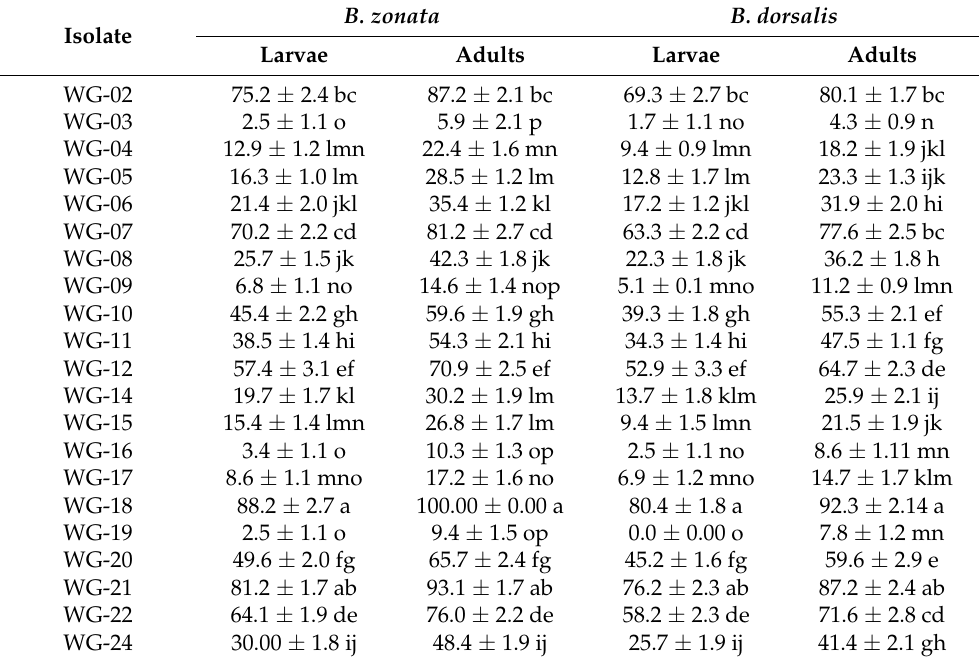
Table 2. Percent mortality (mean ± SEM) of third instar larvae and adults of B. zonata and B. dorsalis when exposed to 21 different isolates of entomopathogenic fungi at 1 × 10 9 conidia mL − 1 . Same let- ters within the column indicate no significant differences between isolates ( p < 0.05; Tukey HSD test). B. Isolate